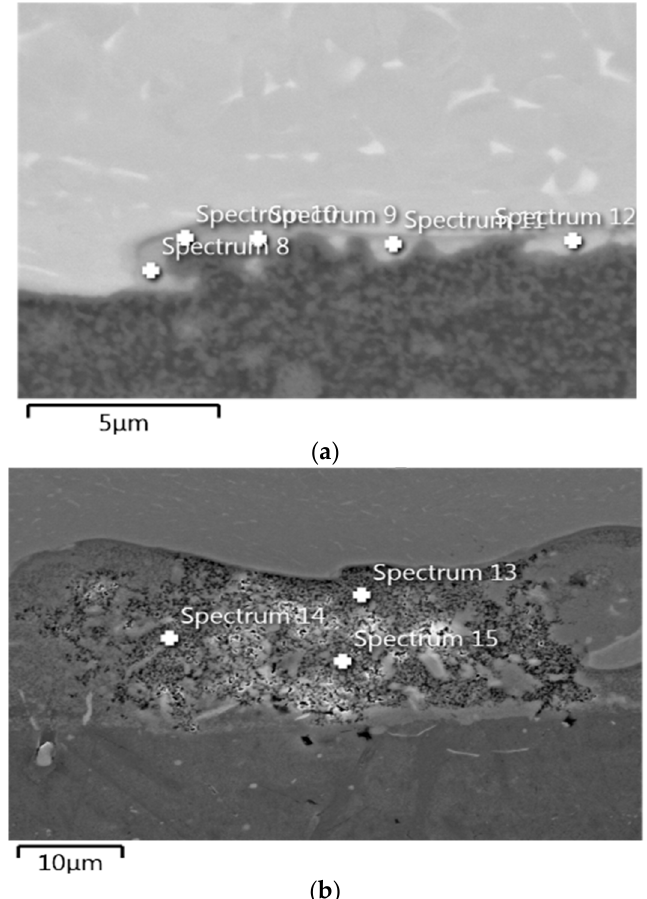
Figure 6. The point of EDS analysis in TZ in aria 1 ( a ) and aria 2 ( b ).